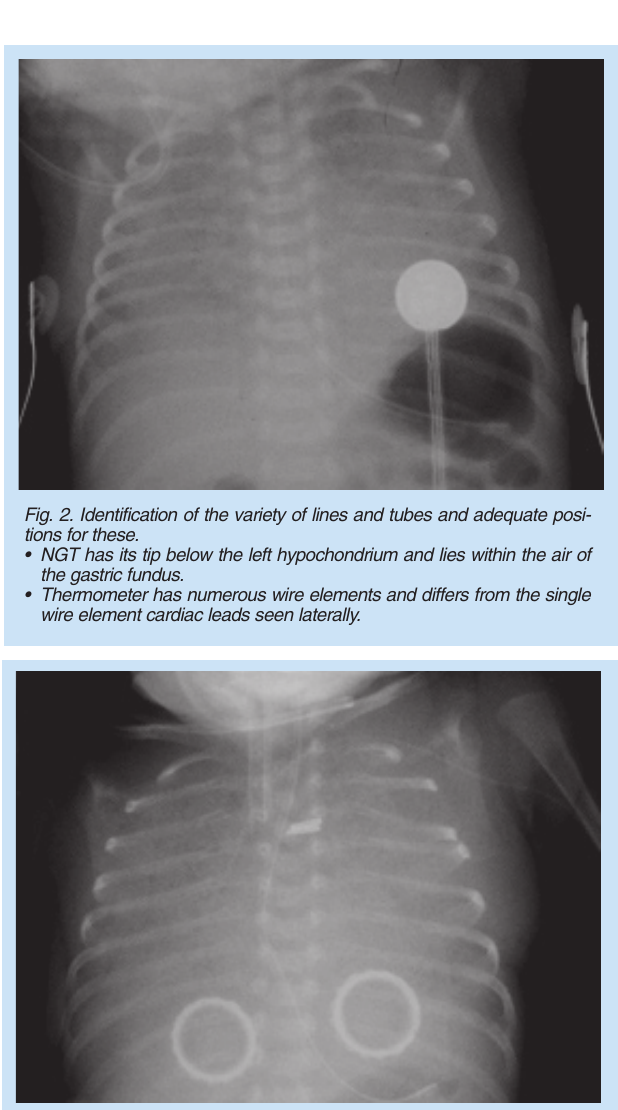
Fig. 3. Identification of the variety of lines and tubes. (capnography) and O monitors have a ‘cog’ type • Cutaneous CO 2 2 outline • The NGT is well sited but the ET-tube is low at the carina.